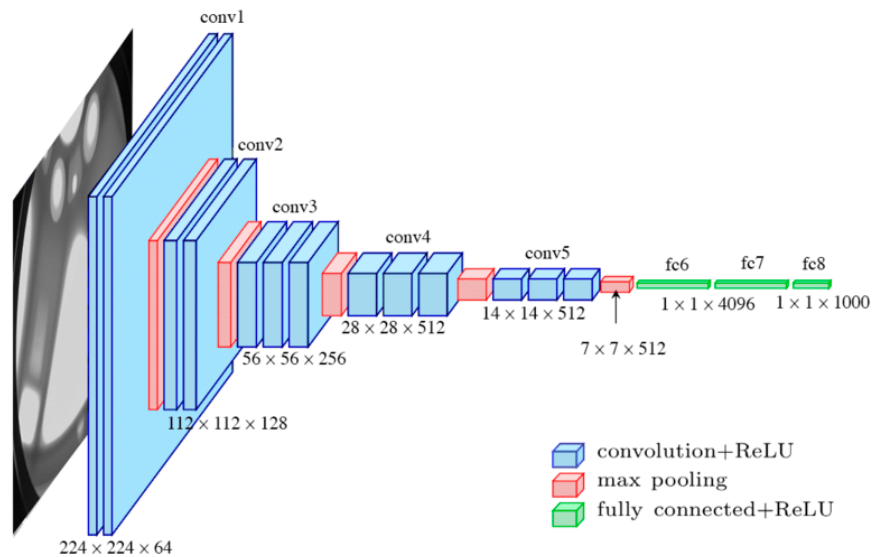
Figure 8. VGG architecture diagram [41].